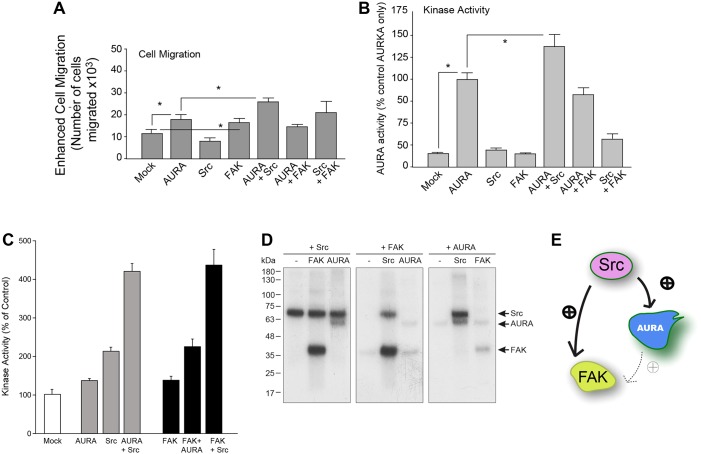
Src and FAK contribute to AURA-mediated cell migration. Effect of overexpression of cell motility proteins on AURA-mediated enhanced cell migration (A) and AURA activity (B). (C,D) Phosphorylation states of purified recombinant AURA, FAK and Src. (C) Kinase activities using purified recombinant AURA, FAK and/or Src as phosphorylation substrate for the relevant kinase of interest, which were then used for filter-binding assays and subsequent liquid scintillation spectrometry. Results were quantified as the mean±s.e.m. percentage activity compared to the control sample. *P<0.05 increases and #P<0.05 decreases between samples and controls. (D) Phosphorylation in-gel analyses of Src, FAK or AURA in the absence or presence of the other kinase. Recombinant proteins were individually incubated with buffer alone or one of the other kinases in a buffer containing [32P]γATP, following which phosphorylation of the kinases was observed by SDS-PAGE and then western blot analyses. (E) Schematic drawing representing activation of upstream Src from the downstream AURA or FAK.